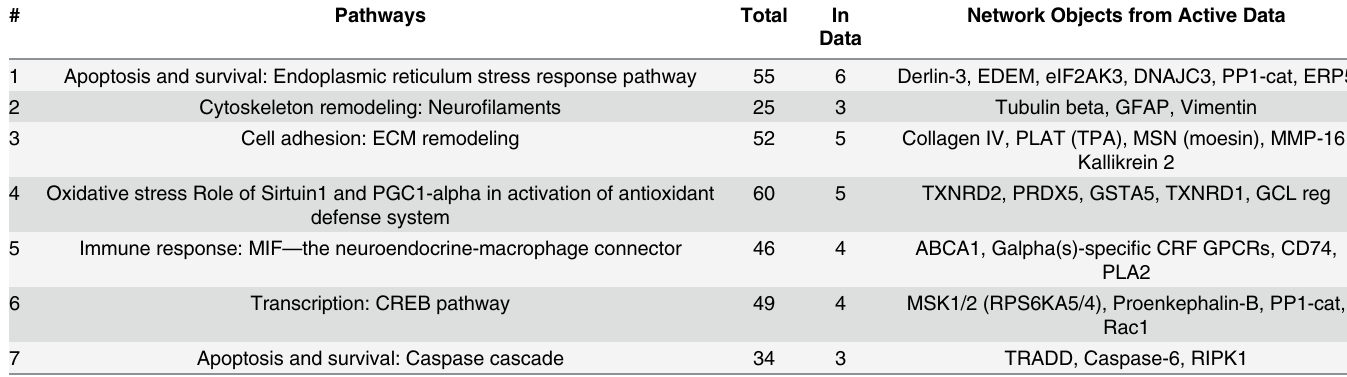
Table 3. Enrichment analysis by pathway maps in the folder 'Huntington Disease' of MetaCore.